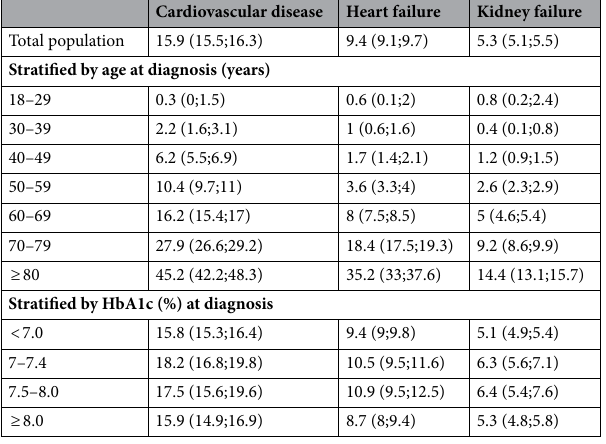
Table 2. Incidence rate of cardiovascular disease, heart failure or kidney failure. Incidence rate per 1000 person years of outcomes with exact 95% Poisson